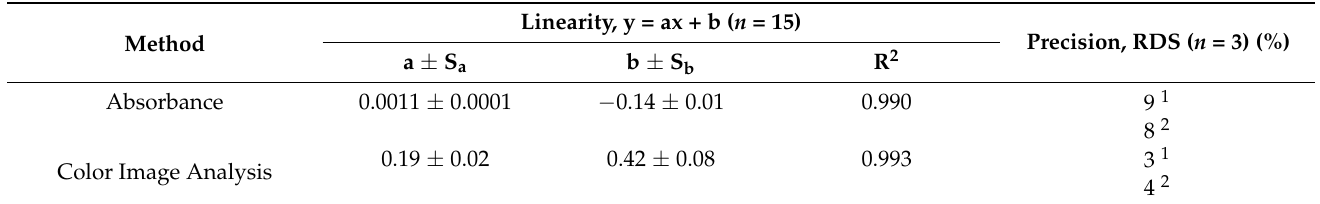
Table 1. Calibration equations and precision obtained for AMP with the proposed method.